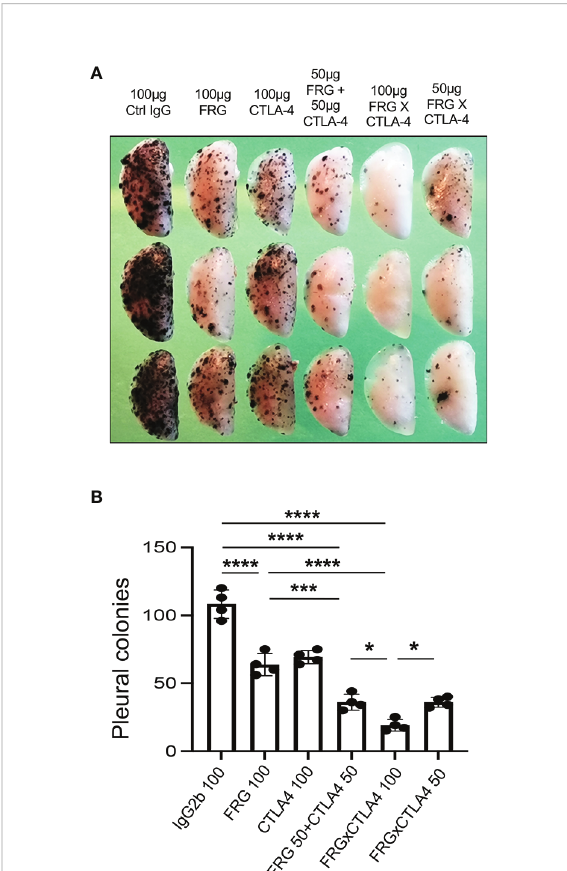
FIGURE 7 Anti-Chi3l1 and anti-CTLA-4 interact to augment antitumor responses in melanoma lung metastasis. WT mice were given B16-F10 (B16) melanoma cells or control vehicle and treated with control IgG, FRG and or anti-CTLA-4 antibodies, alone or in combination, and melanoma lung metastasis was evaluated 2 weeks later. (A) Representative lungs from mice treated with control IgG, FRG and or anti-CTLA-4 antibodies, alone or in combination. They were compared to the mice treated with indicated doses of the bispeci fi c antibody FRG-CTLA-4. As noted, the antibodies were given at doses of 100 m g or 50 m g every other day by intra-peritoneal injection. (B) The number of pleural melanoma colonies was quantitated in the lungs from the mice in panel (A) Each dot is representative of an individual animal. Panel (A) is a representative of at least 3 evaluations. The values in panel (B) represent the mean±SEM of the evaluations represented by the individual dots in the lungs from the experiment representatively illustrated in panel (A) * P < 0.05. *** P < 0.001; **** P < 0.0001. (ANOVA with multiple